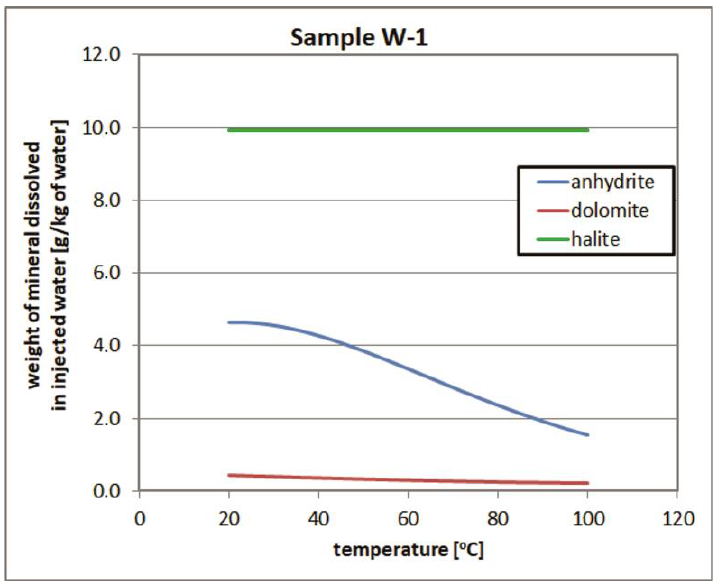
Figure 7. Changes in solubility of rock matrix minerals in W-1 injected water as function of temperature.